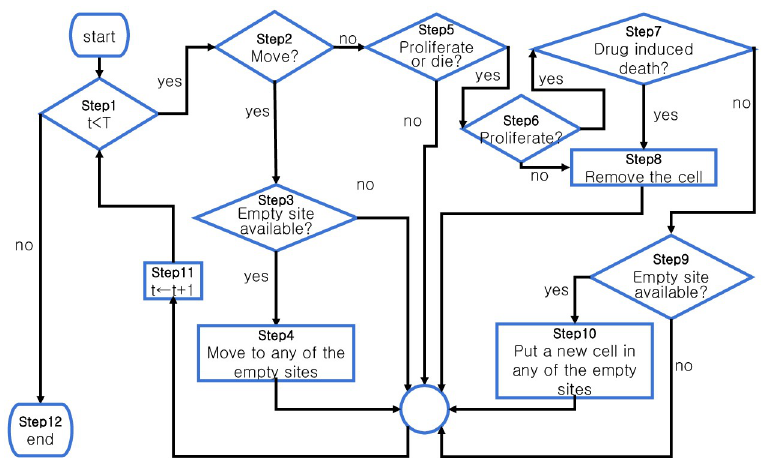
Fig 3. Cells’ life cycle. Flow chart of the cells’ life cycle. In each time step, all of the cells follow the steps in the flow